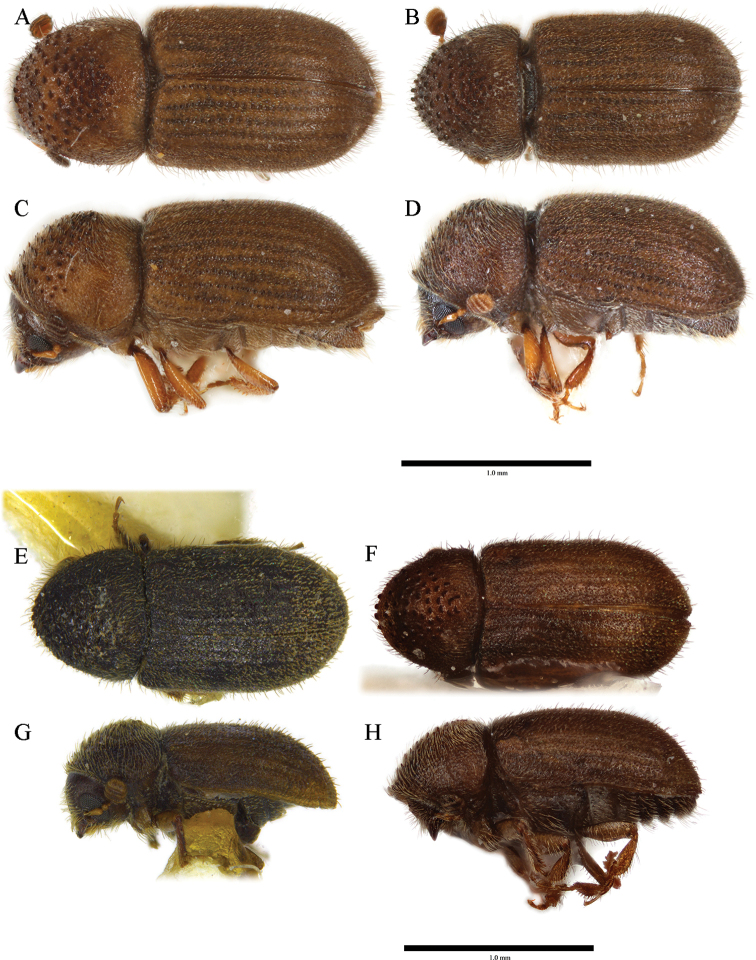
A–DCryphalus
scopigerA, C female, UFFE:33471 B, D male, UFFE:33472 E–HCryphalus
viburniE, G paralectotypes (2 different specimens, sex unknown), UFFE:34767 F, H male, UFFE:31842 [H is flipped horizontally].